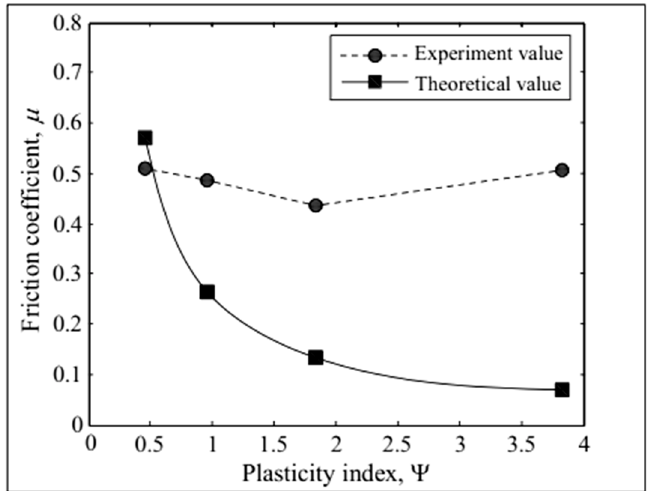
Figure 9. Friction coefficient versus plasticity index.